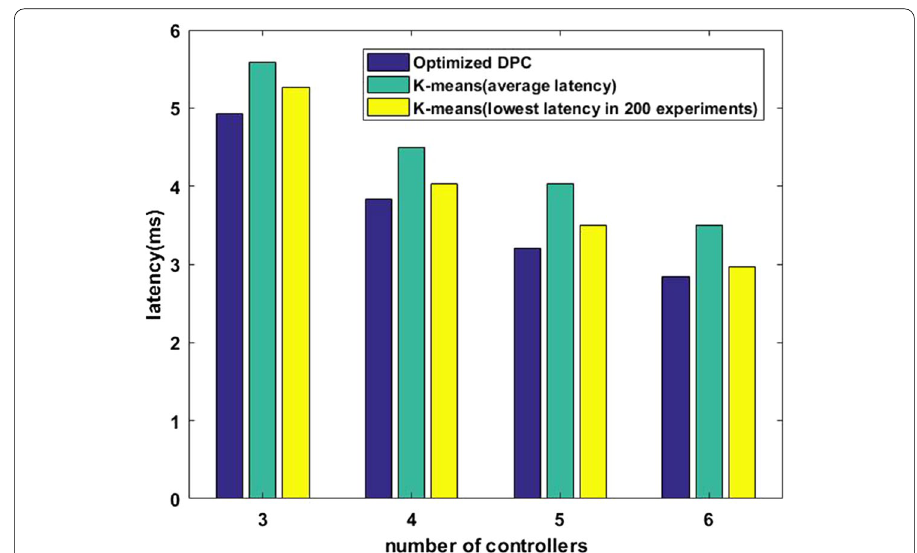
Fig. 5 Comparison of latency under different algorithms. x axis: number of controllers. y axis: latency(ms): Among the 200 experimental data obtained by K-means algorithm, we calculate the average communication delay and the minimum communication delay, and compare these data with the optimized DPC algorithm